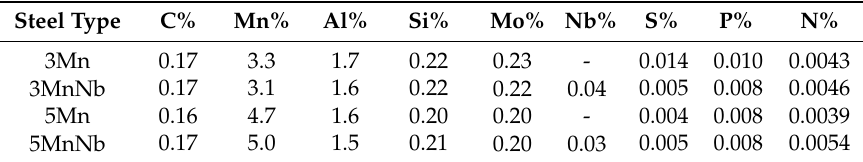
Table 1. Chemical composition of investigated steels in wt. %.